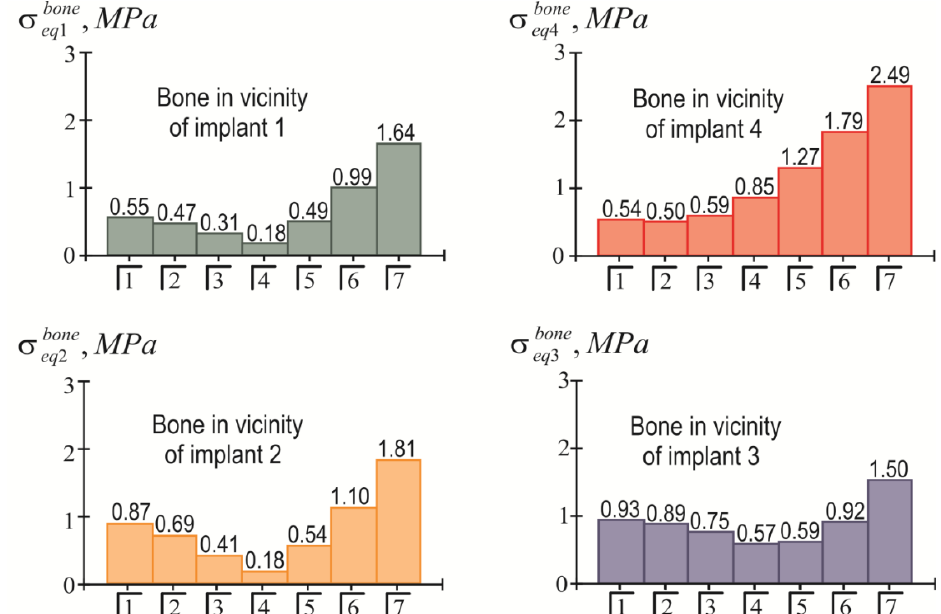
Figure 10. Dependence of maximum equivalent stresses in bone tissue on the location of the mas- tication load (the first variant of implant placement).